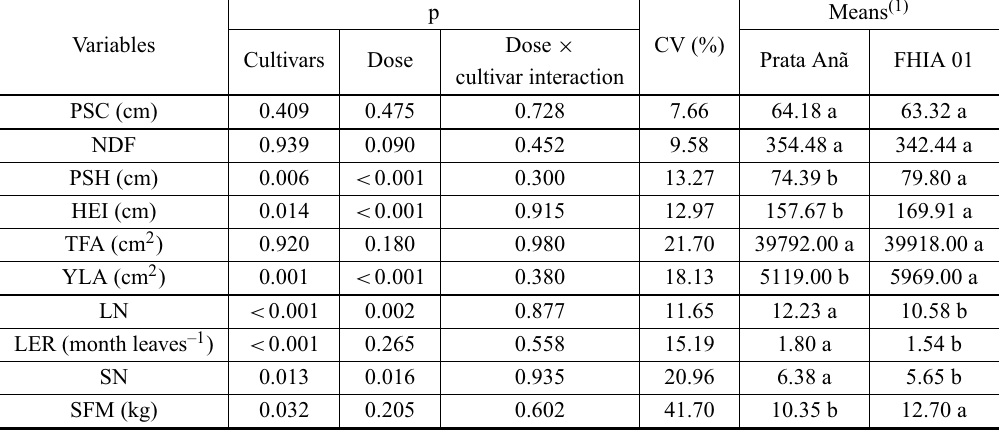
F test probability values of the analysis of variance (p), coefficient of variation (CV%) and mean per cultivar for the variables: pseudostem circumference (PSC), number of days from planting to flowering (NDF), pseu- dostem height (PSH), plant height (HEI), total foliar area (TFA), foliar area of the totally expanded youngest leaf (YLA), leaf number (LN), leaf emission rate (LER), sucker number (SN), sucker fresh mass (SFM).